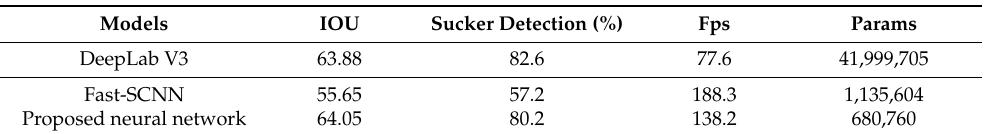
Table 8. The comparison of Class IOU, Fps, and Params (the number of parameters) between models on the Tomato dataset.